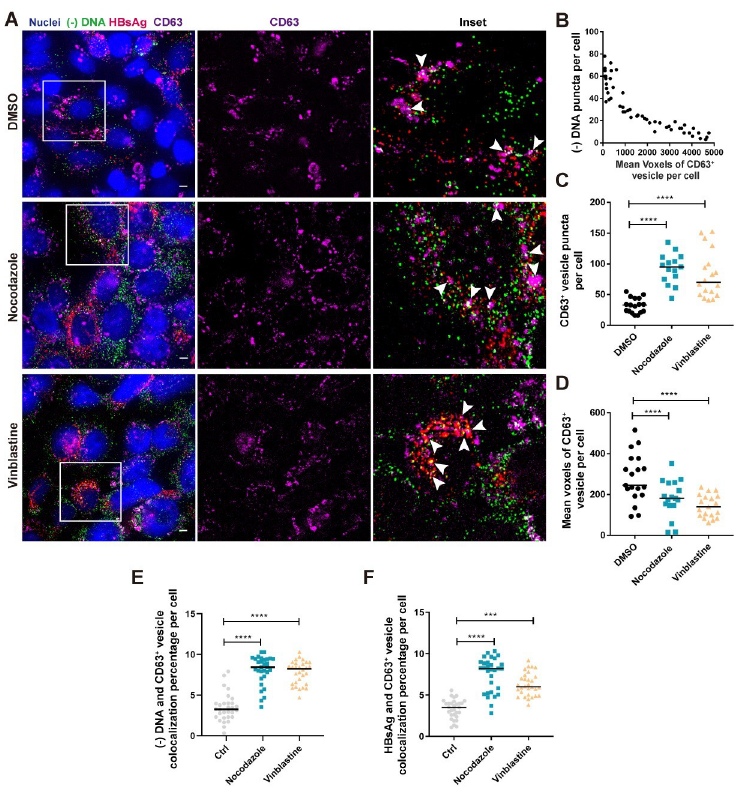
Fig 7. MTs orchestrate HBV virion secretion by regulating MVBs morphogenesis. (A) HepAD38 cells were fixed and processed for detecting HBV (-) DNA, HBsAg and MVBs specific marker CD63. Specific enlargement of the area within the white-outlined box, colocalization of (-) DNA, HBsAg and CD63 were presented by white arrows. Scale bar, 4 μ m. (B) Quantification of images in DMSO-treated cells and analyzing the relationship between the mean volume of CD63 + vesicles and (-) DNA puncta in each cell. (C, D) Mean volume and puncta of CD63 + vesicles in a single cell level were measured by Huygens. Analyzing (-) DNA and CD63 + positive (E), HBsAg and CD63 + positive (F) colocalization percent per cell within 3 μ m. More than 15 cells per group was counted. ���� P < 0.0001 (Mann-Whitney U-test).